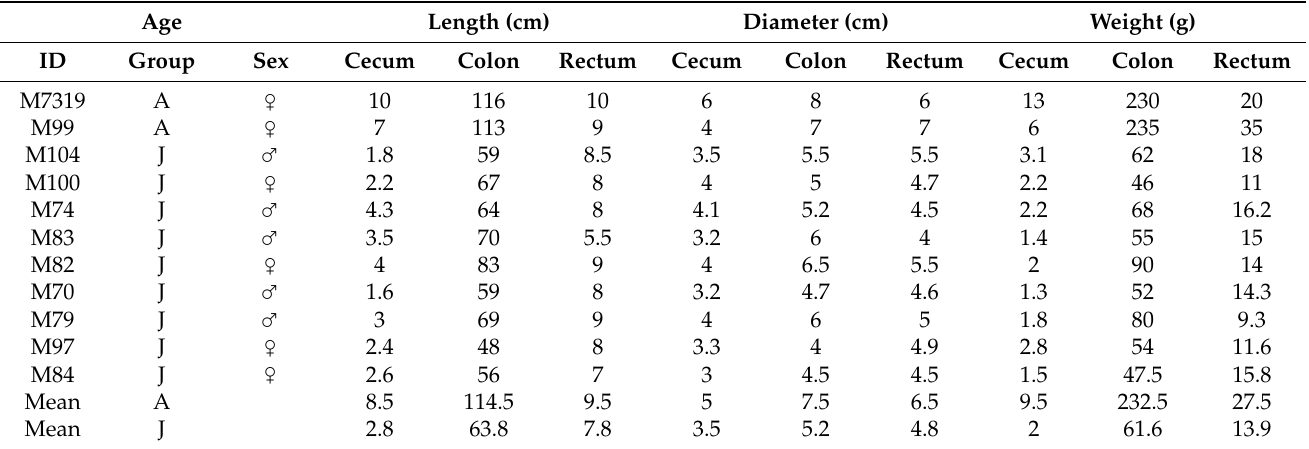
Table 5. Morphometric data of the large intestine proceeding of the 11 specimens of Arctocephalus australis used in the present study. A: adult; J: juvenile.